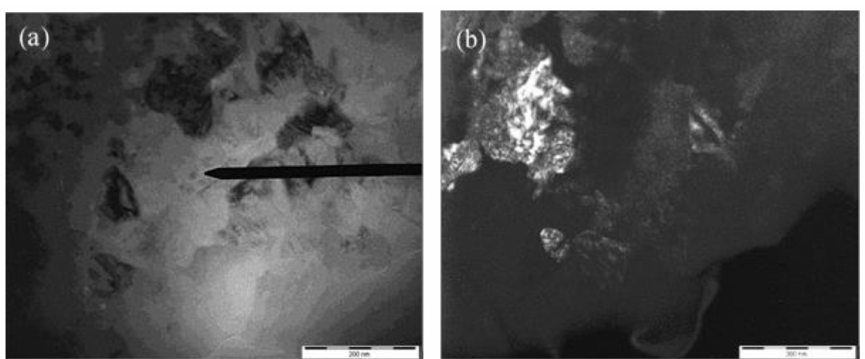
Figure 7. Electron microscopic images of the thin structure of detonation coating based on Ti 3 SiC 2 before and after pulse-plasma treatment: ( a )—brightfield image before the PPT, ( b )—darkfield image after the